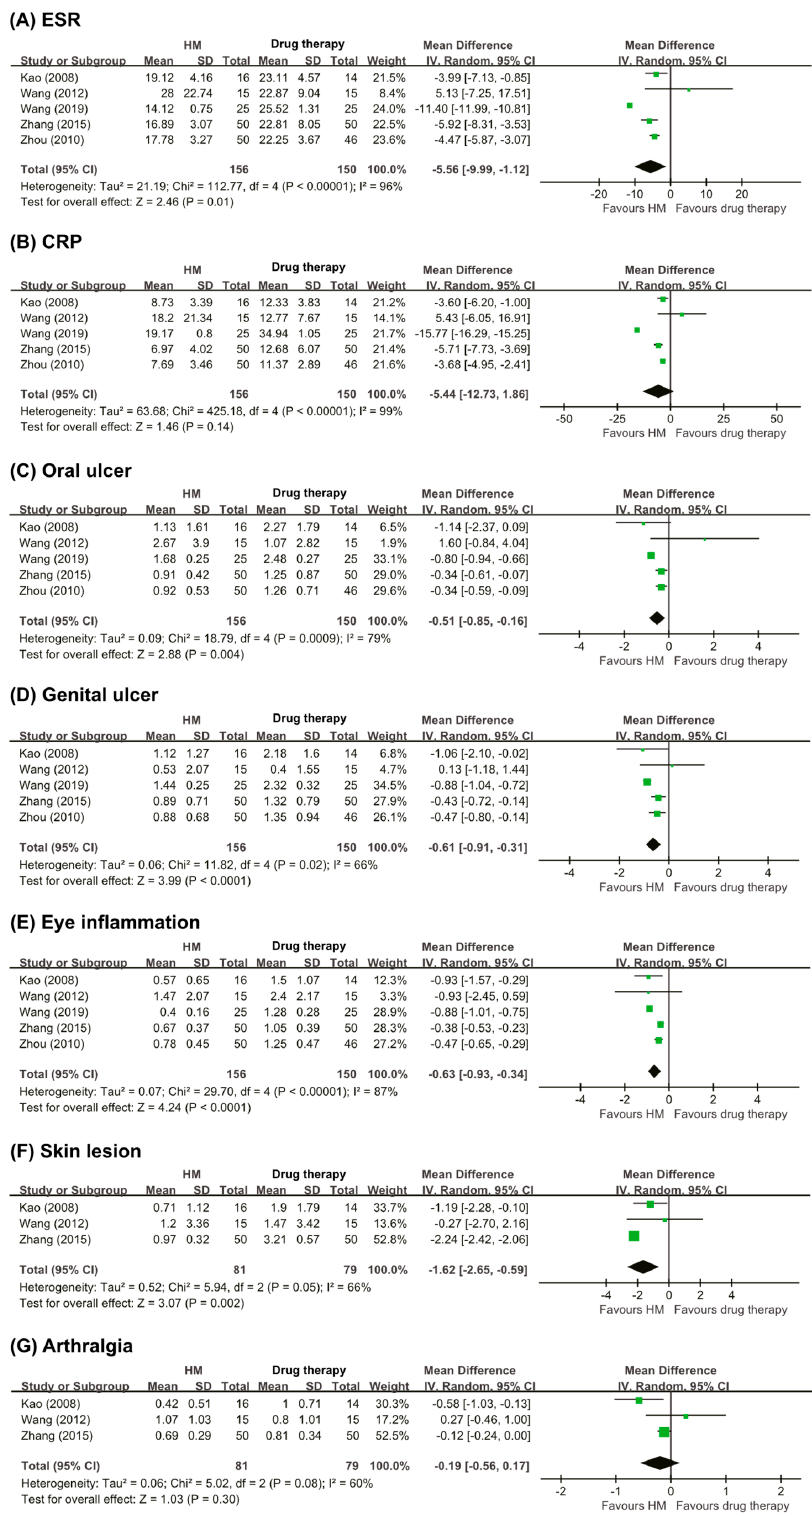
Figure 4. Forest plots of symptoms score ( A ) ESR, ( B ) CRP, ( C ) oral ulcer, ( D ) genital ulcer, ( E ) Eye inflammation, ( F ) skin lesions, and ( G ) arthralgia. CRP: C-reactive protein; ESR: erythrocyte sedimentation rate; HM: herbal medicine.